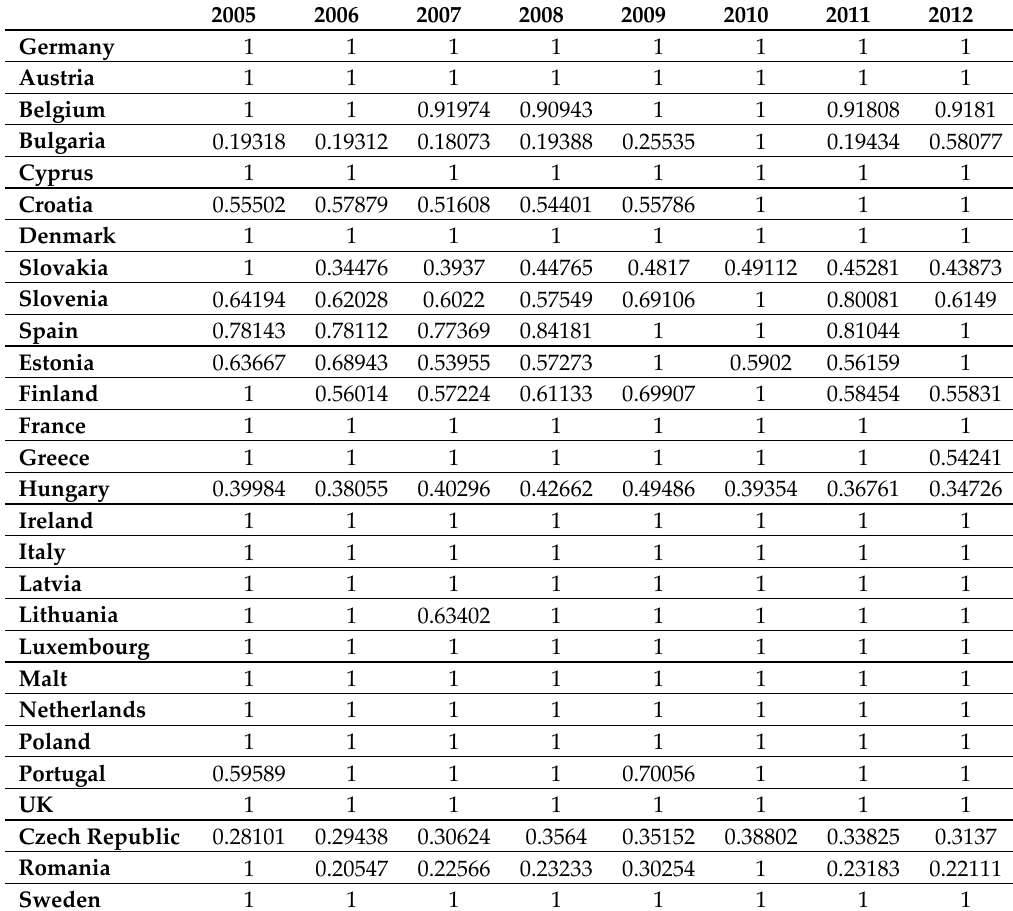
Table 3. Environmental efficiency data for the 28 countries of the European Union during the 2005– 2012 period obtained with the DEA Method 1. Source: own calculations.